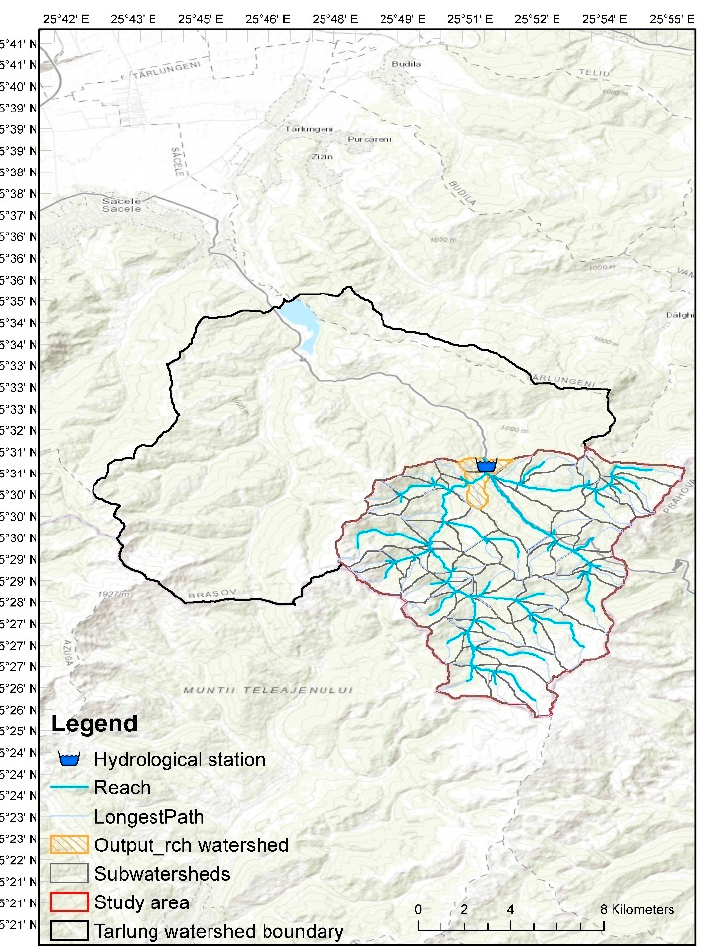
Figure 1. Upper Tarlung watershed. The land within the Upper Tarlung watershed comprises 50% deciduous forests, 30% evergreen forests, 19% pastures, and 1% is covered by pastures with scattered trees, meadows, water bodies, rocky lands, public roads, and built-up area (Figure 2). The main soil types within the watershed are Dystric Cambosols, Prepodzols, and Eutric Cambisoils which account for 60%, 16%, and 15%, respectively (Figure